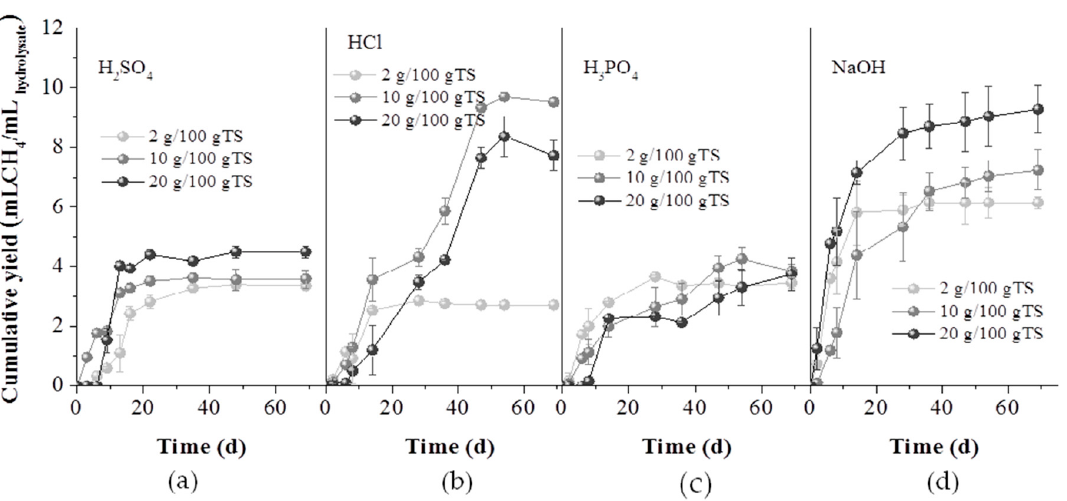
Figure 6. Cumulative methane yield of the hydrolysates obtained from GL waste pretreated with H 2 SO 4 ( a ), HCl ( b ), H 3 PO 4 ( c ) and NaOH ( d ), at the concentrations of 2, 10 and 20 g / 100 gTS,